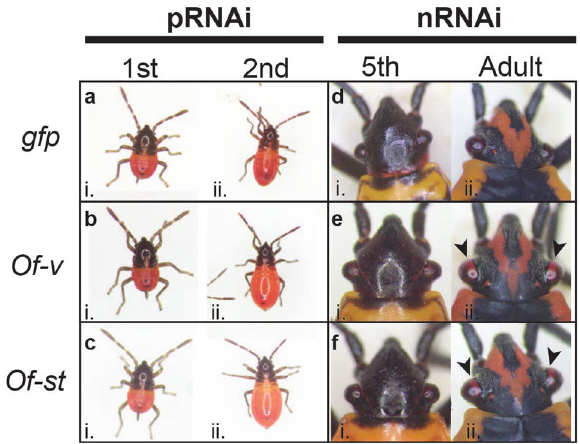
Figure 2. RNAi knockdown of ommochrome pathway genes Of-st and Of-v results in loss of brown eye pigmentation. Photos of nymphs and adults, as indicated. ( A ) Offspring of females injected with a gfp dsRNA control exhibit wild type phenotypes at first (i), second (ii) instars. Offspring of females injected with ( B ) Of-v dsRNA or ( C ) Of-st dsRNA. Fourth instar nymphs were injected with ( D ) gfp , ( E ) Of-v , or ( F ) Of-st dsRNA, shown after molting to fifth instar (i) and adulthood (ii). While gfp dsRNA-treated individuals display wild type black eyes, those treated with either Of-v or Of-st dsRNA display clear loss of brown eye pigment in the new ommatidia along the medial border of the adult compound eye ( Eii,Fii ,